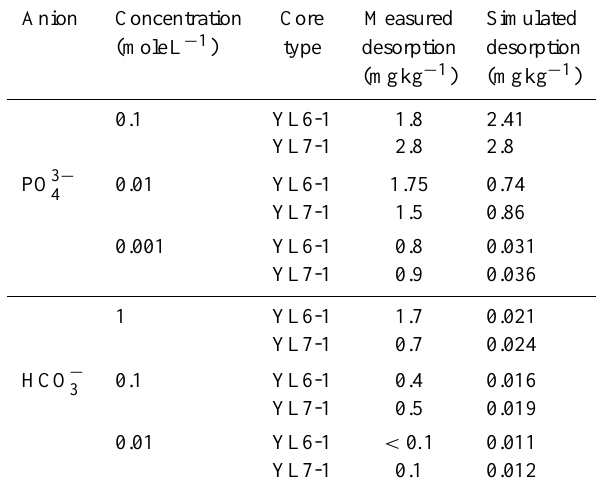
Table 3. Thermodynamic data of surface complexation constants for arsenite, arsenate, phosphate, sulfate and carbonate (Allison et al., 1990; van Geen et al., 2004).